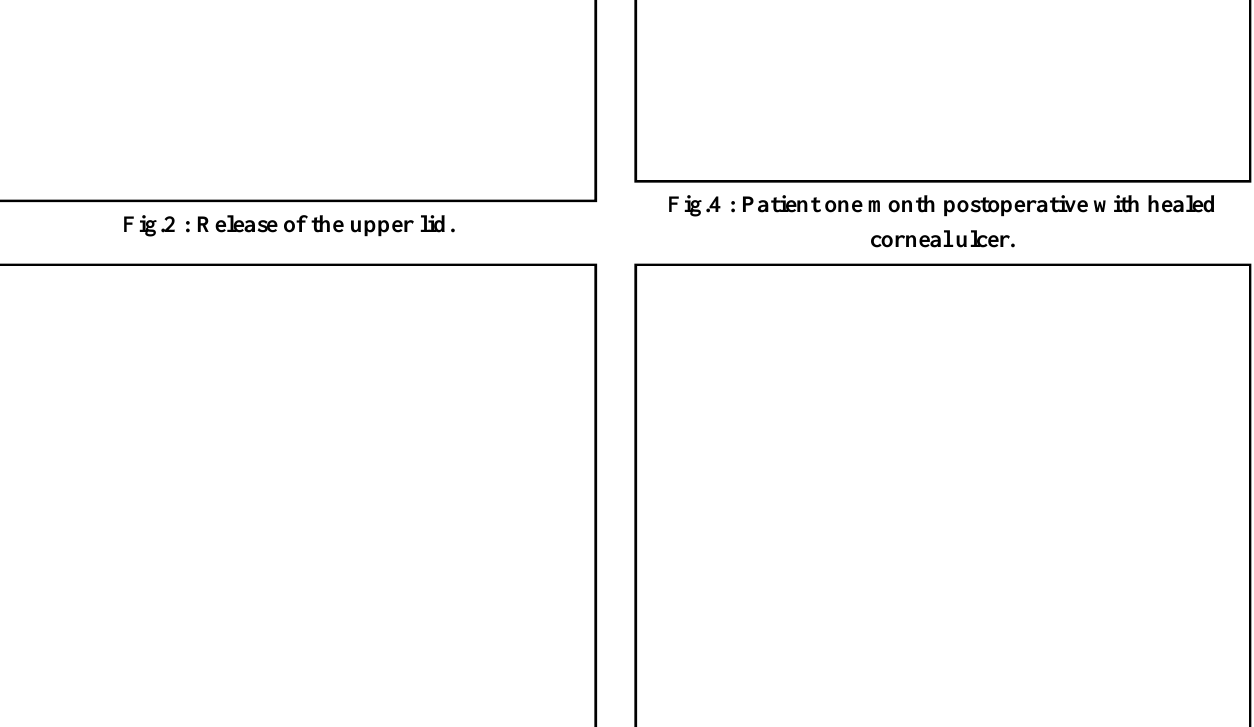
Fig.5 : Four month postoperative following release of